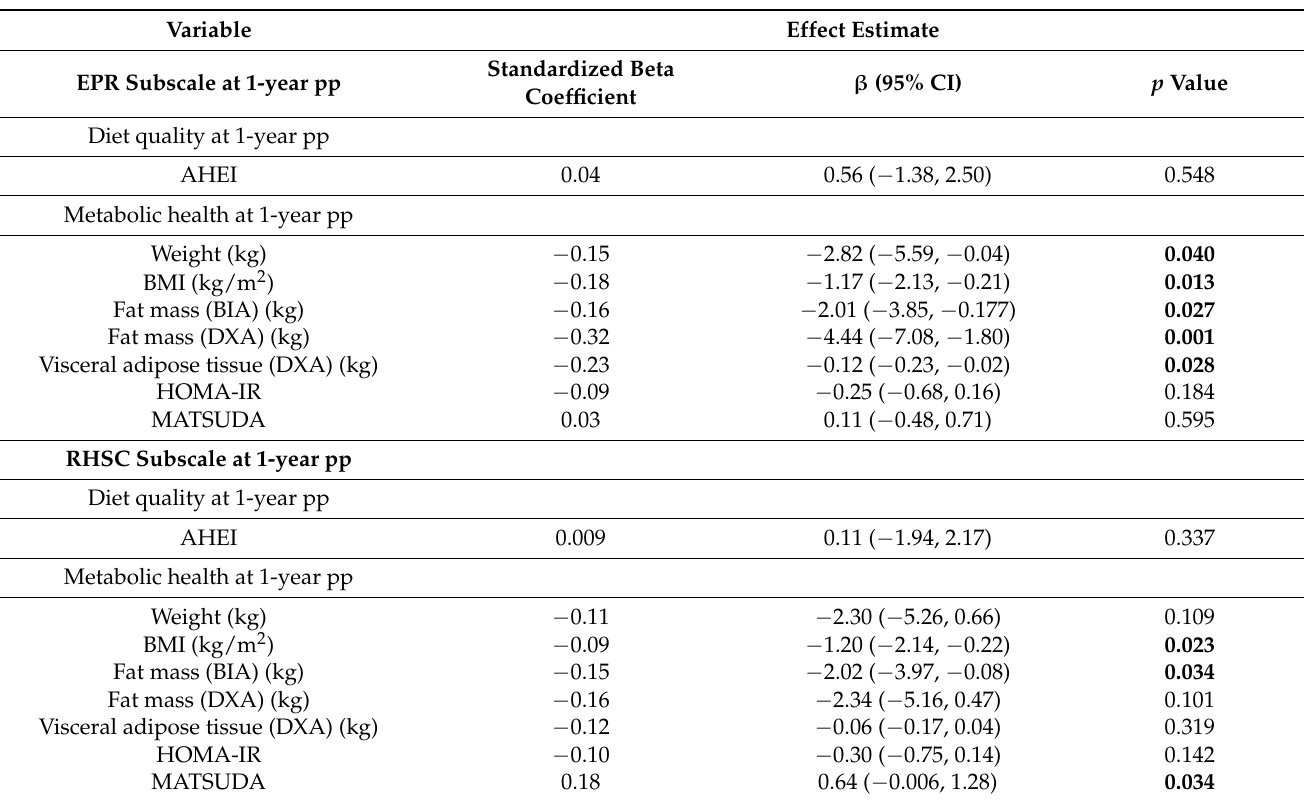
Table 3. Cross-sectional associations between the two subscales of intuitive eating with diet quality and metabolic health outcomes at 1-year